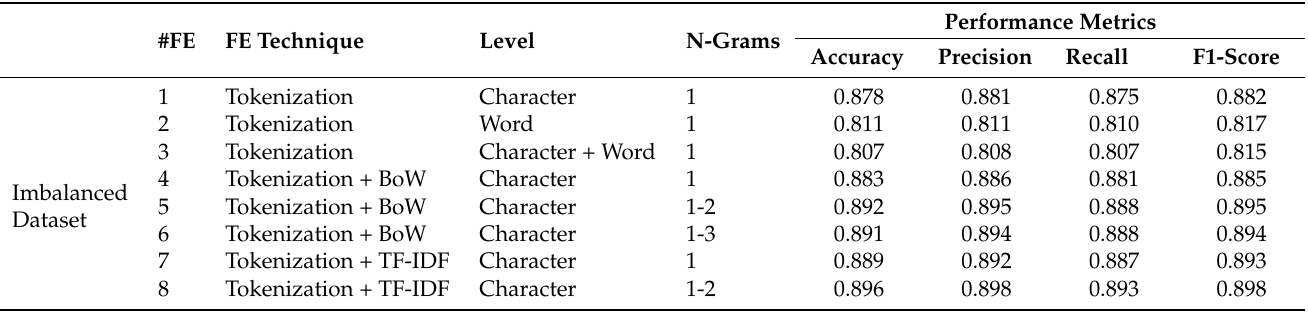
Table 6. Performance of the proposed model with different FE techniques on imbalanced and oversampled